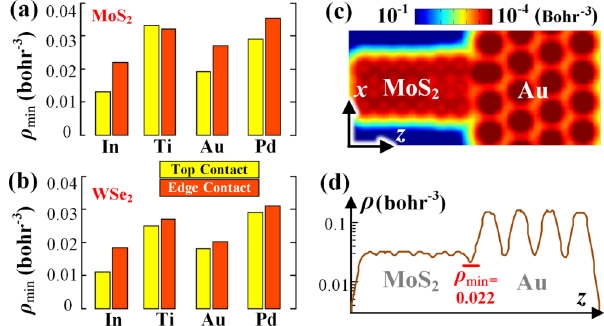
of (a) Au-MoS 2 edge contact and eff